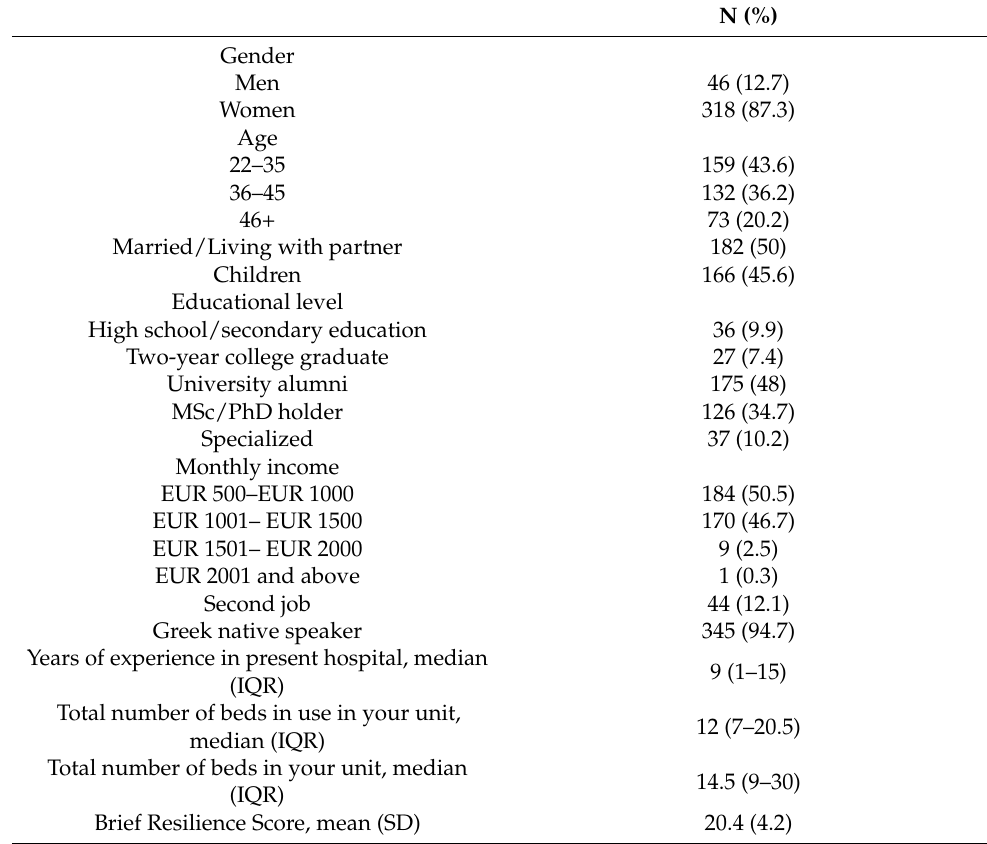
Table 1. Participants’